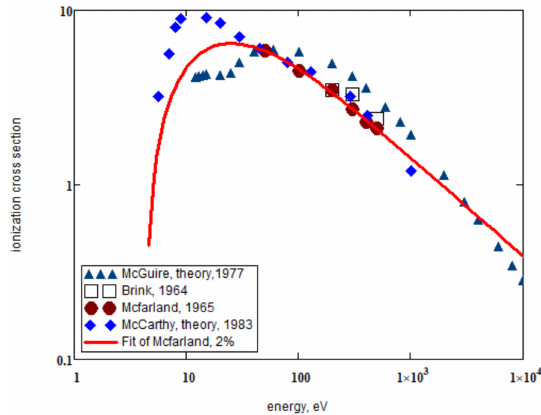
Figure 4. Electron impact ionization of potassium in Å 2